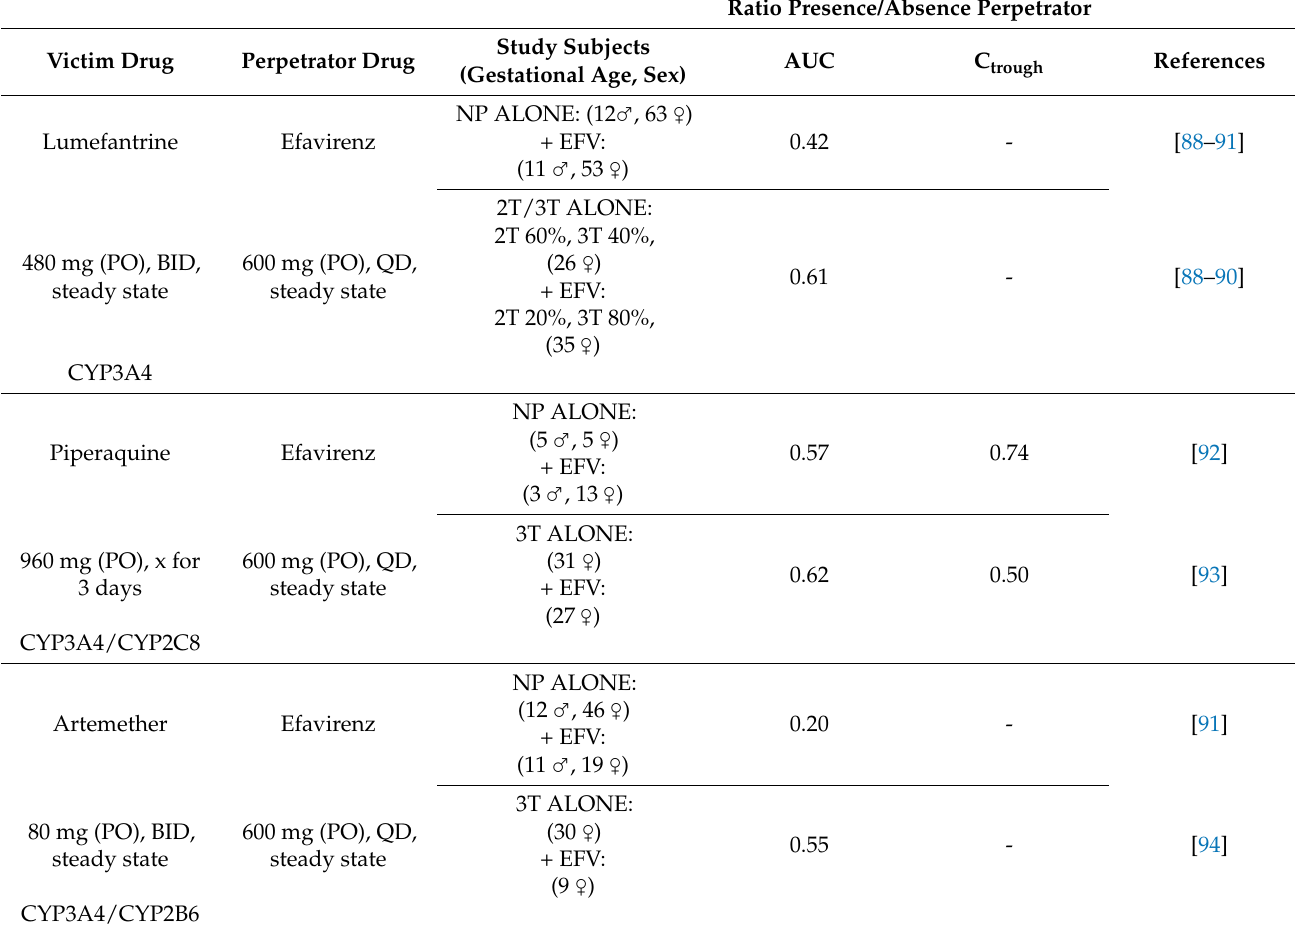
Legend: 2T, second trimester; 3T, third trimester; AUC, area under the curve; BID, twice a day; C trough trough concentration at steady state; EFV, efavirenz; NP, non-pregnant; PO, oral administration; QD, once a day. The mean and the geometric mean of the raw pharmacokinetic data were used to calculate the corresponding